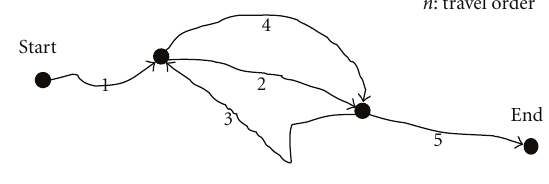
Figure 5: An example of order routes.